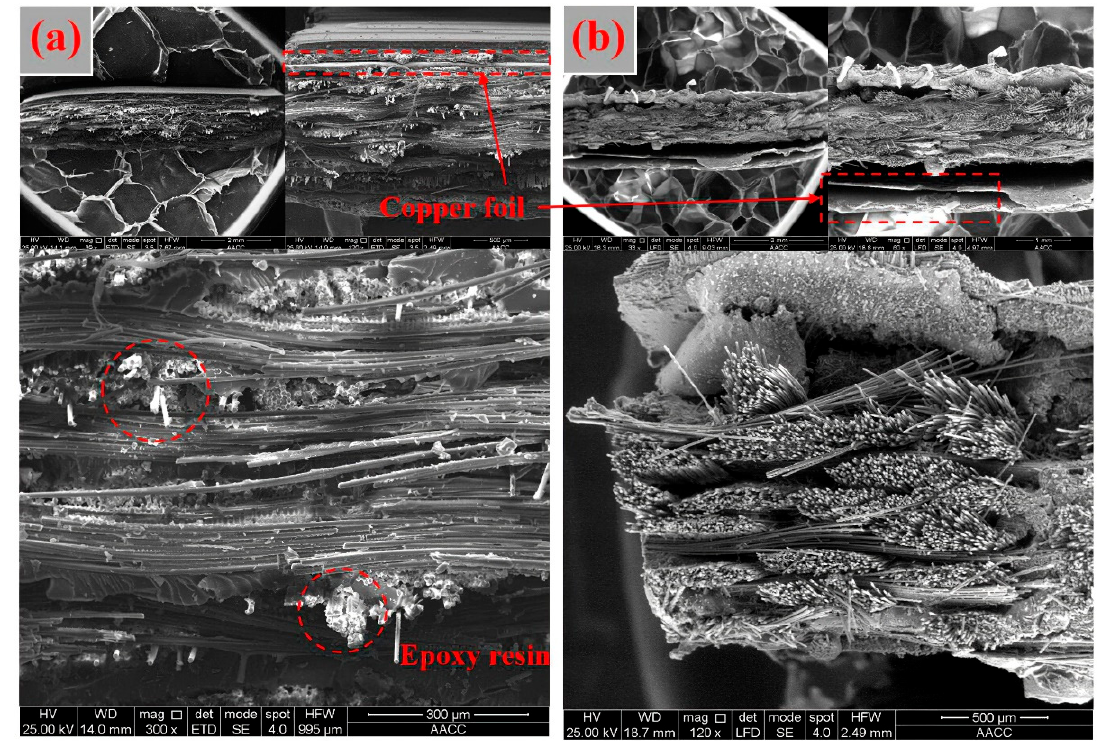
Figure 3. The SEM of the morphology of unheated ( a ) and heat treated ( b ) PCBs.